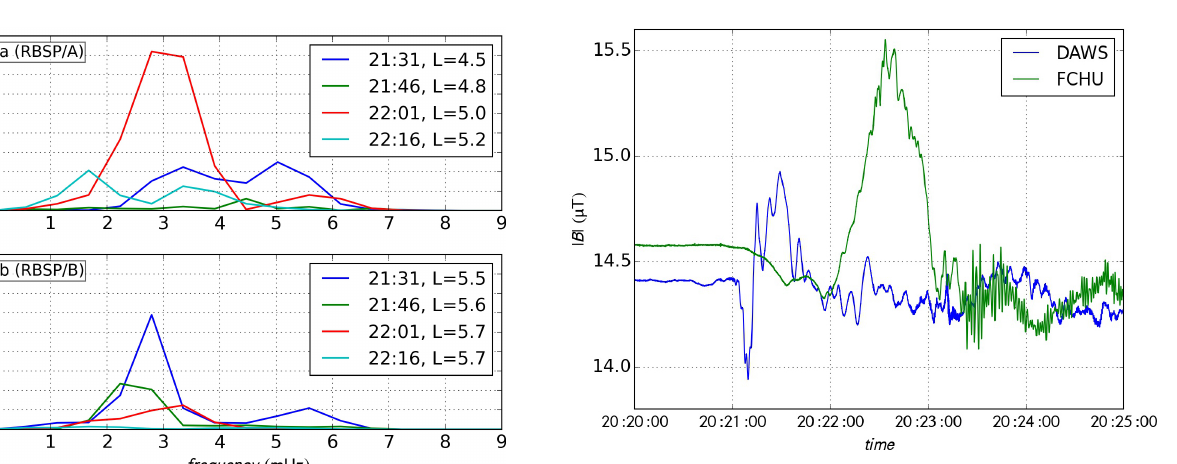
Figure A1. Power spectral density at 21:31, 21:46, 22:01 and 22:16UT. Note that data are band-pass-filtered between 1 and 6mHz.